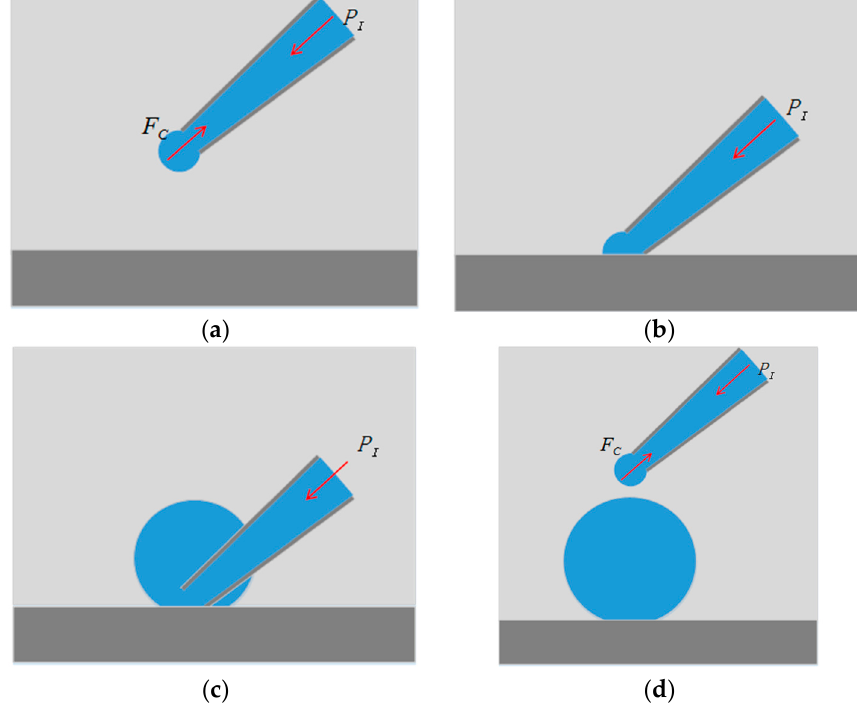
Figure 2. Substrate-contacting method. ( a ) The micropipette is immersed in the oil-phase liquid medium and adjusted to a certain injection pressure; ( b ) the micropipette is moved down to contact the substrate, resulting in the collapse of the interface at the micropipette opening; ( c ) the Laplace pressure in the microdroplet is no longer relevant once the liquid contacts the substrate, allowing the liquid to flow out from the micropipette; ( d ) the micropipette is lifted, causing the microdroplet to dispense from the micropipette, and the Laplace pressure reappears and balances the injection pressure; thus, the micropipette returns to the equilibrium state.